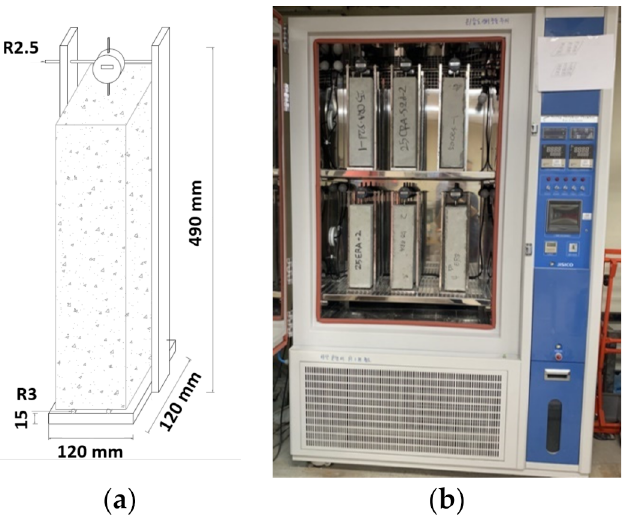
Figure 4. Experimental specimens with a dial-gauge installed: ( a ) schematic diagram and ( b ) picture.